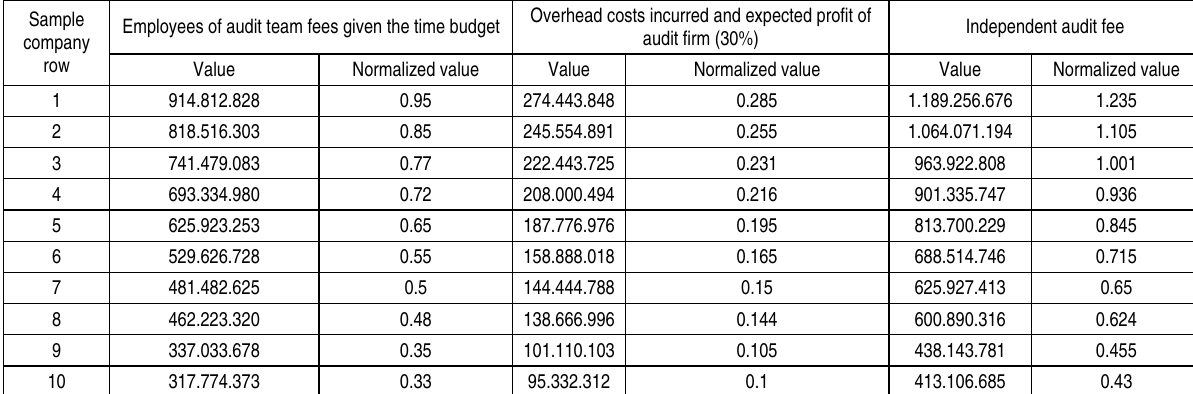
Table 10. Audit fees predicted for 10 sample companies